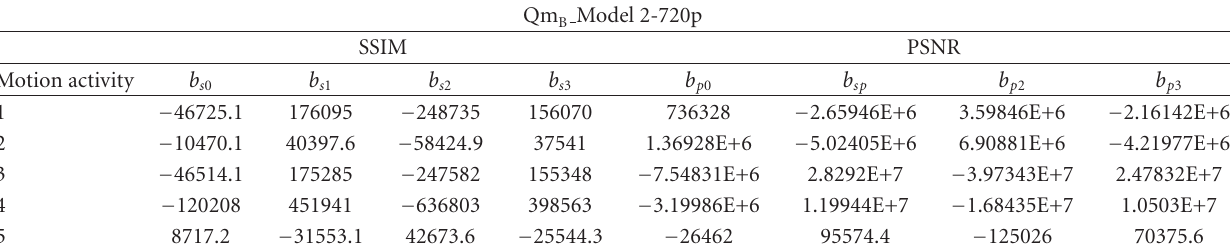
Table 7: Coe ffi cients for the second model of Qm B .